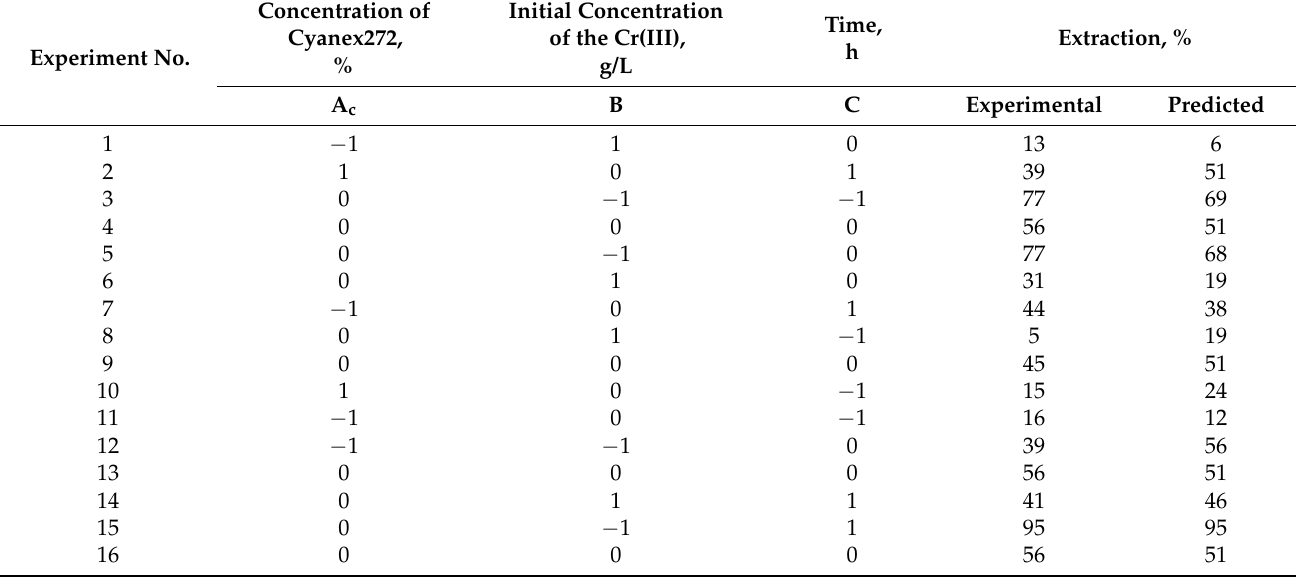
Table 4. BBD design of process variables for experiment and values of experimental data for extraction of Cr(III) ions using DCSLM with threshold concentration of D2EHPA and different proportions of Cyanex272.